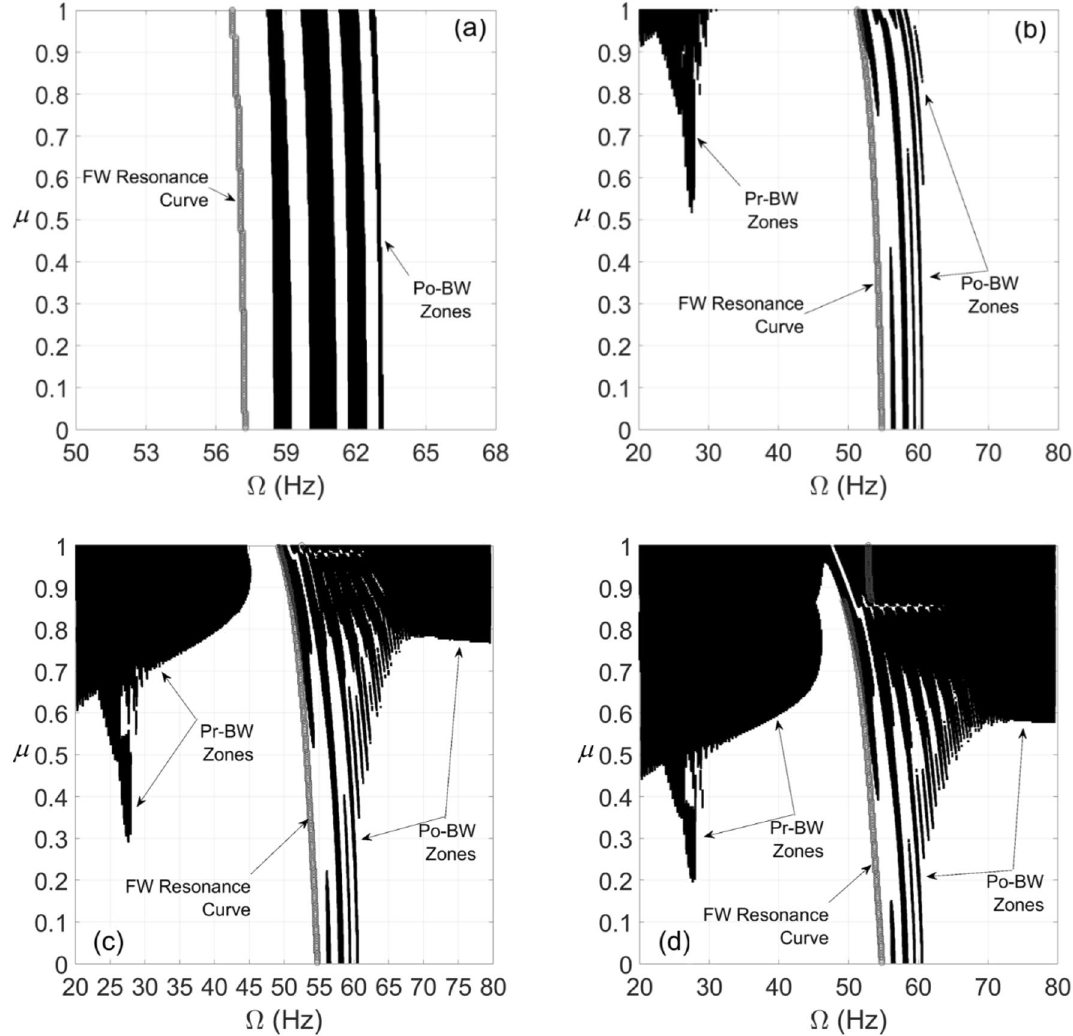
Figure 14. BW zones of rotational speeds at varying normalized crack depths of an overhung cracked rotor system for the crack located ( a ) at the first element, ( b ) at the second element, ( c ) at the third element, and ( d ) at 2 3 rad and ρ = 3 . the fourth element for α = 50 rad/s , β = 2 π (cid:31)